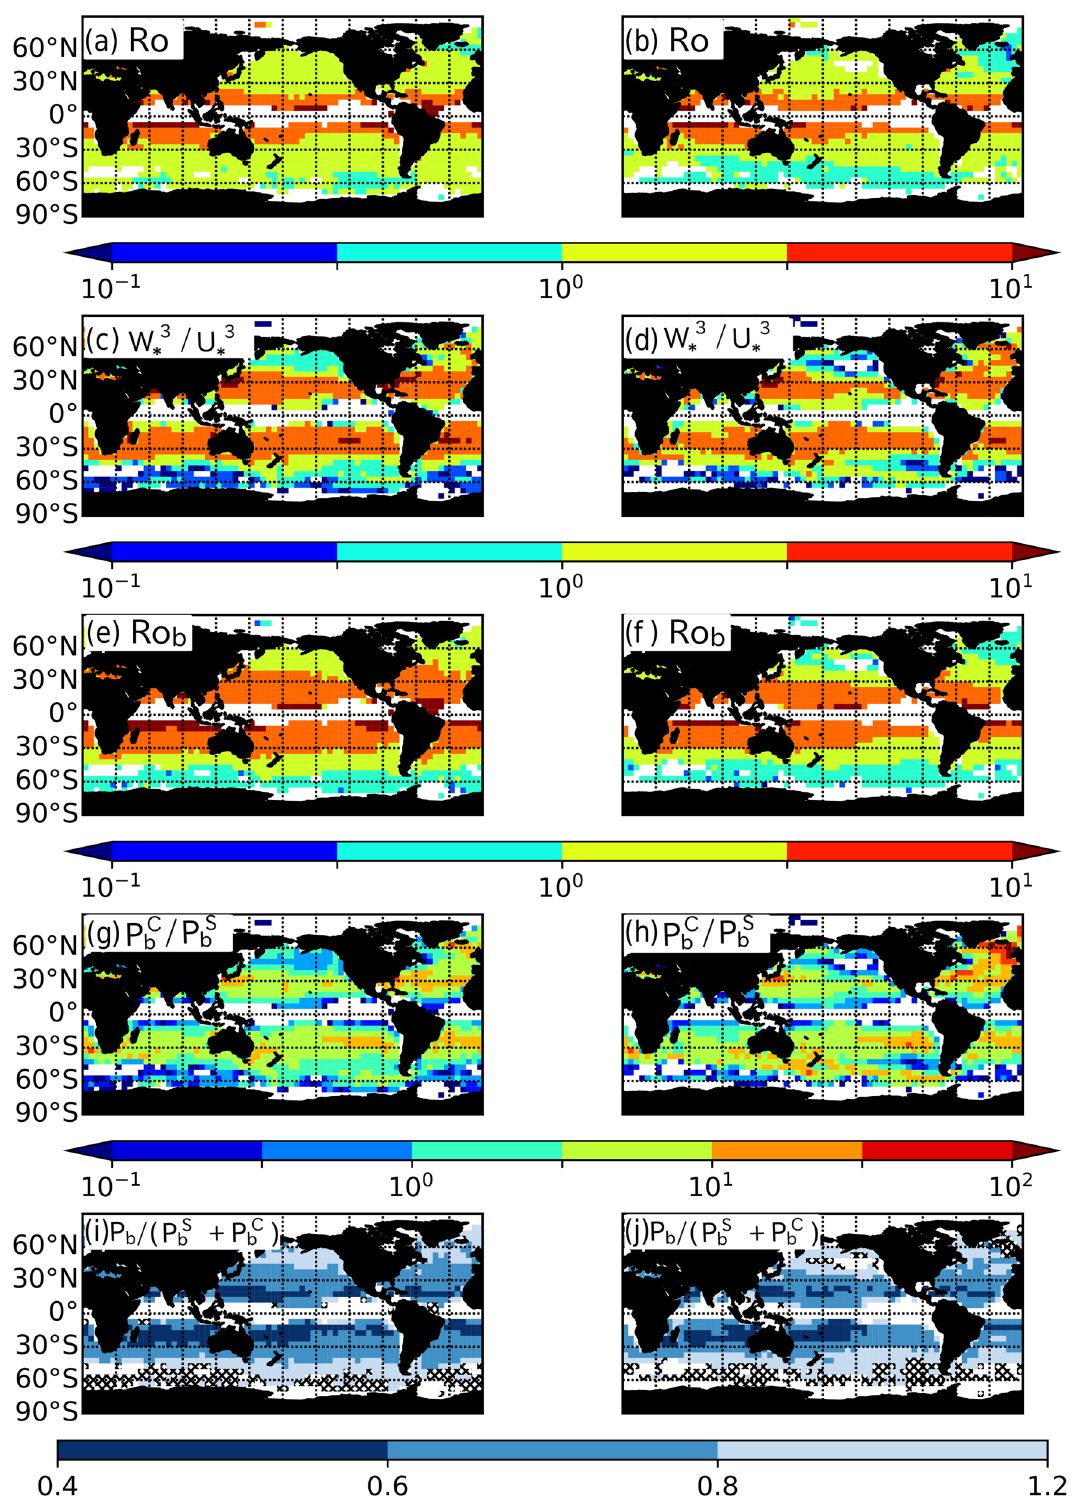
/ U 3 , (e), (f) ∗ ∗ ) , and P b /( P S / U 3 ∗ ∗